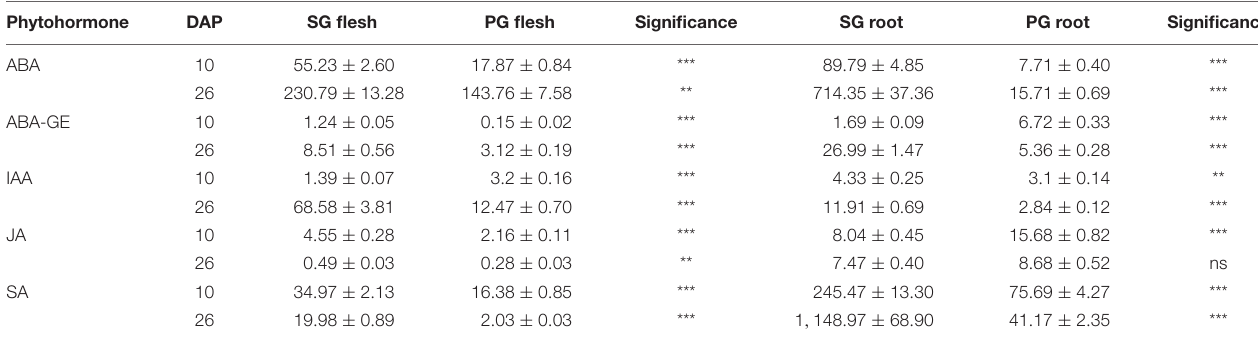
TABLE 1 | Phytohormone patterns of the flesh and root tissues in watermelon self-grafted (SG) plant and pumpkin-grafted (PG) plant. Phytohormone